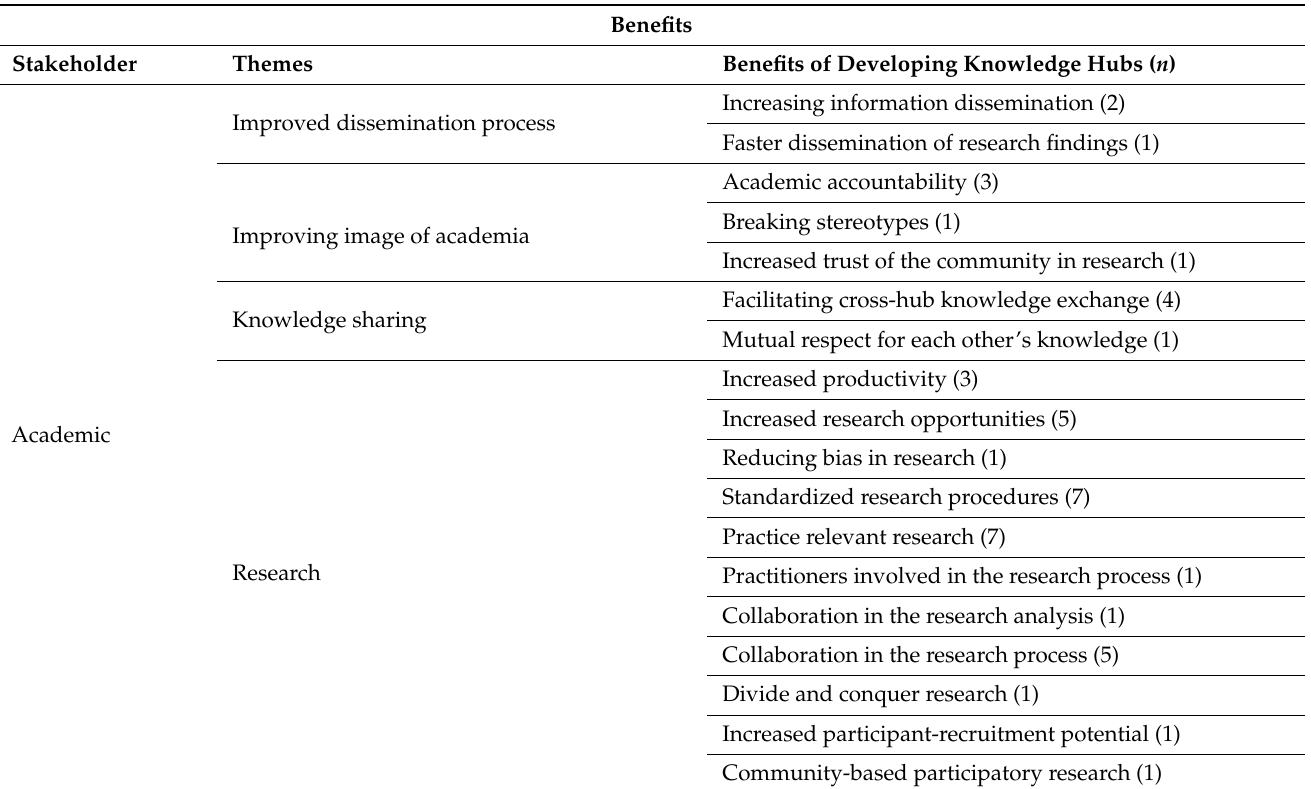
Table 5. Benefits of and challenges for developing knowledge